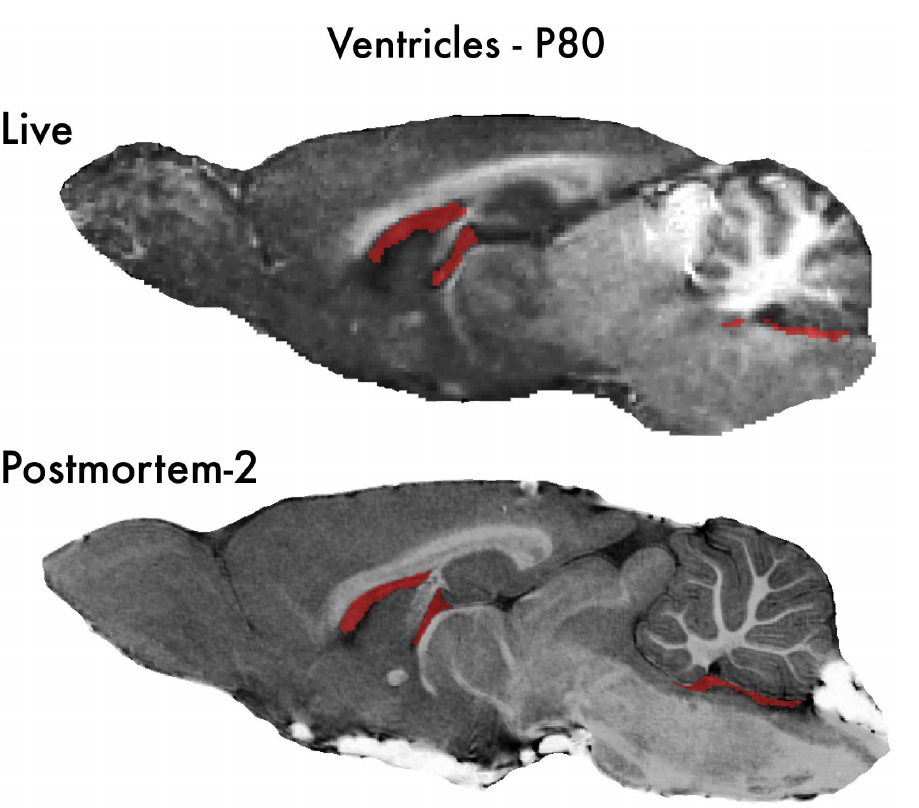
Figure 5. Ventricles in Live and Postmortem brains. Sagittal sections that highlight the lateral ventricles are shown for a live and Postmortem-2 brain scan of a P80 young adult animal. Ventricular spaces are highlighted in red. Note the post mortem image shows clear brain regional morphology, whereas the live image shows discretization artifacts in the highlights. These differences in image quality would be expected to improve segmentation accuracy and quantification of ventricles similar to other brain regions. However, the ventricles are fluid-filled spaces that are more likely to be altered by post mortem procedures. Although our ventricular volumes were not statistically different in live vs post mortem comparisons, at each age studied there is an apparent trend of reduced volumes from live to Postmortem-1 and Postmortem-2, which suggests post mortem ventricular values should be interpreted with particular caution compared to the other brain regions of interest.